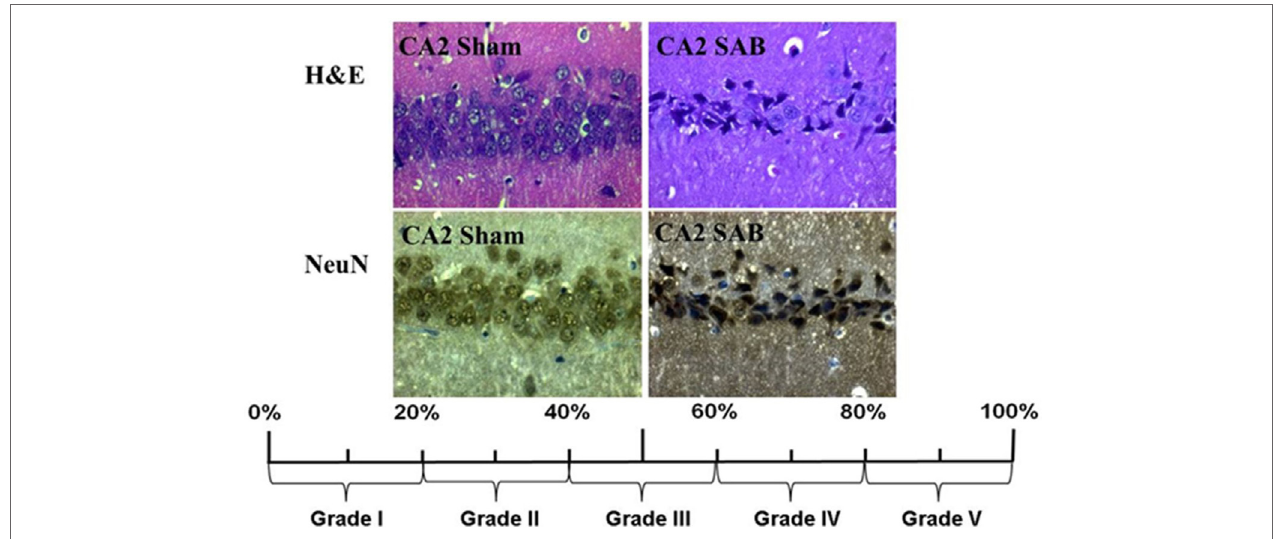
Figure 3 | Histopathological severity score. Neuronal cell damage was evaluated in H&E and NeuN staining. Damaged neurons, characterized by hypereosinophilia, shrunken cytoplasm, and pyknotic nuclei, were software assisted counted and expressed as a ration to the total cell count per region. The resulting percentage was converted into grade 1 to grade